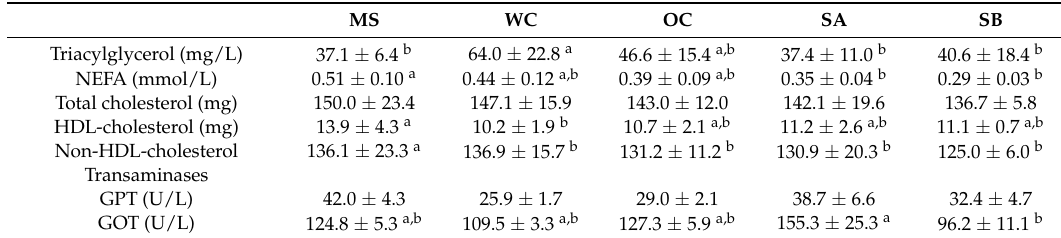
Table 2. Serum parameters in rats fed on the experimental